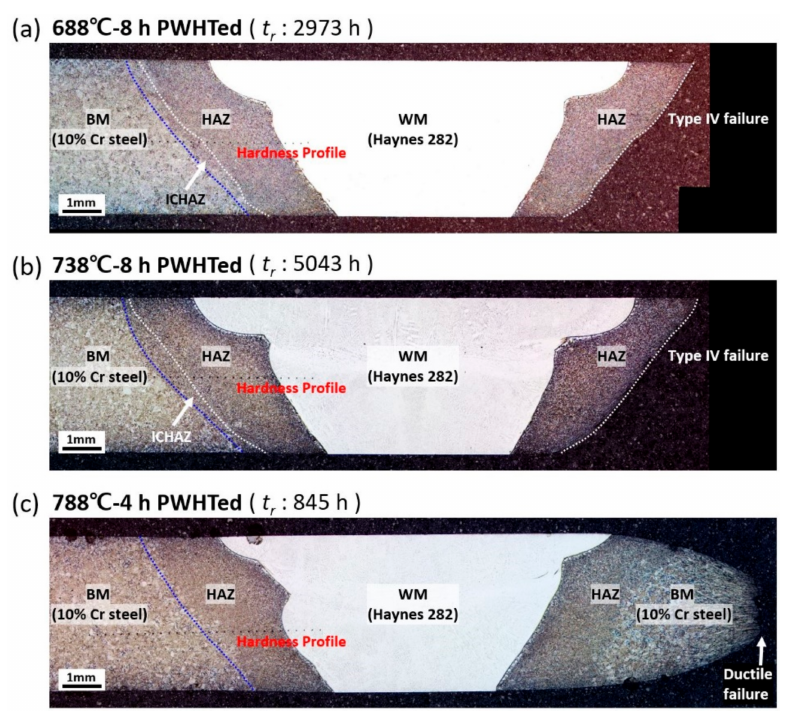
Figure 3. Cross-sectional images of creep specimens with different PWHT conditions: ( a ) 688 ◦ C-8 h; ( b ) 738 ◦ C-8 h; and ( c ) 788 ◦ C-4 h PWHTed specimens. Hardness profiles across the weldments in as-welded 688 ◦ C-8 h, 738 ◦ C-8 h, and 788 ◦ C-4 h PWHT conditions before and after the creep test at 600 ◦ C/200 MPa are shown in Figure 4. Hardness after the creep test was measured on a cross-section of the nonfractured side of the specimens (Figure 3). Based on the results of the hardness measurements and microstructural observation, fusion line, coarse-grained HAZ (CGHAZ), FGHAZ, ICHAZ, over-tempered zone (OTZ), and BM were